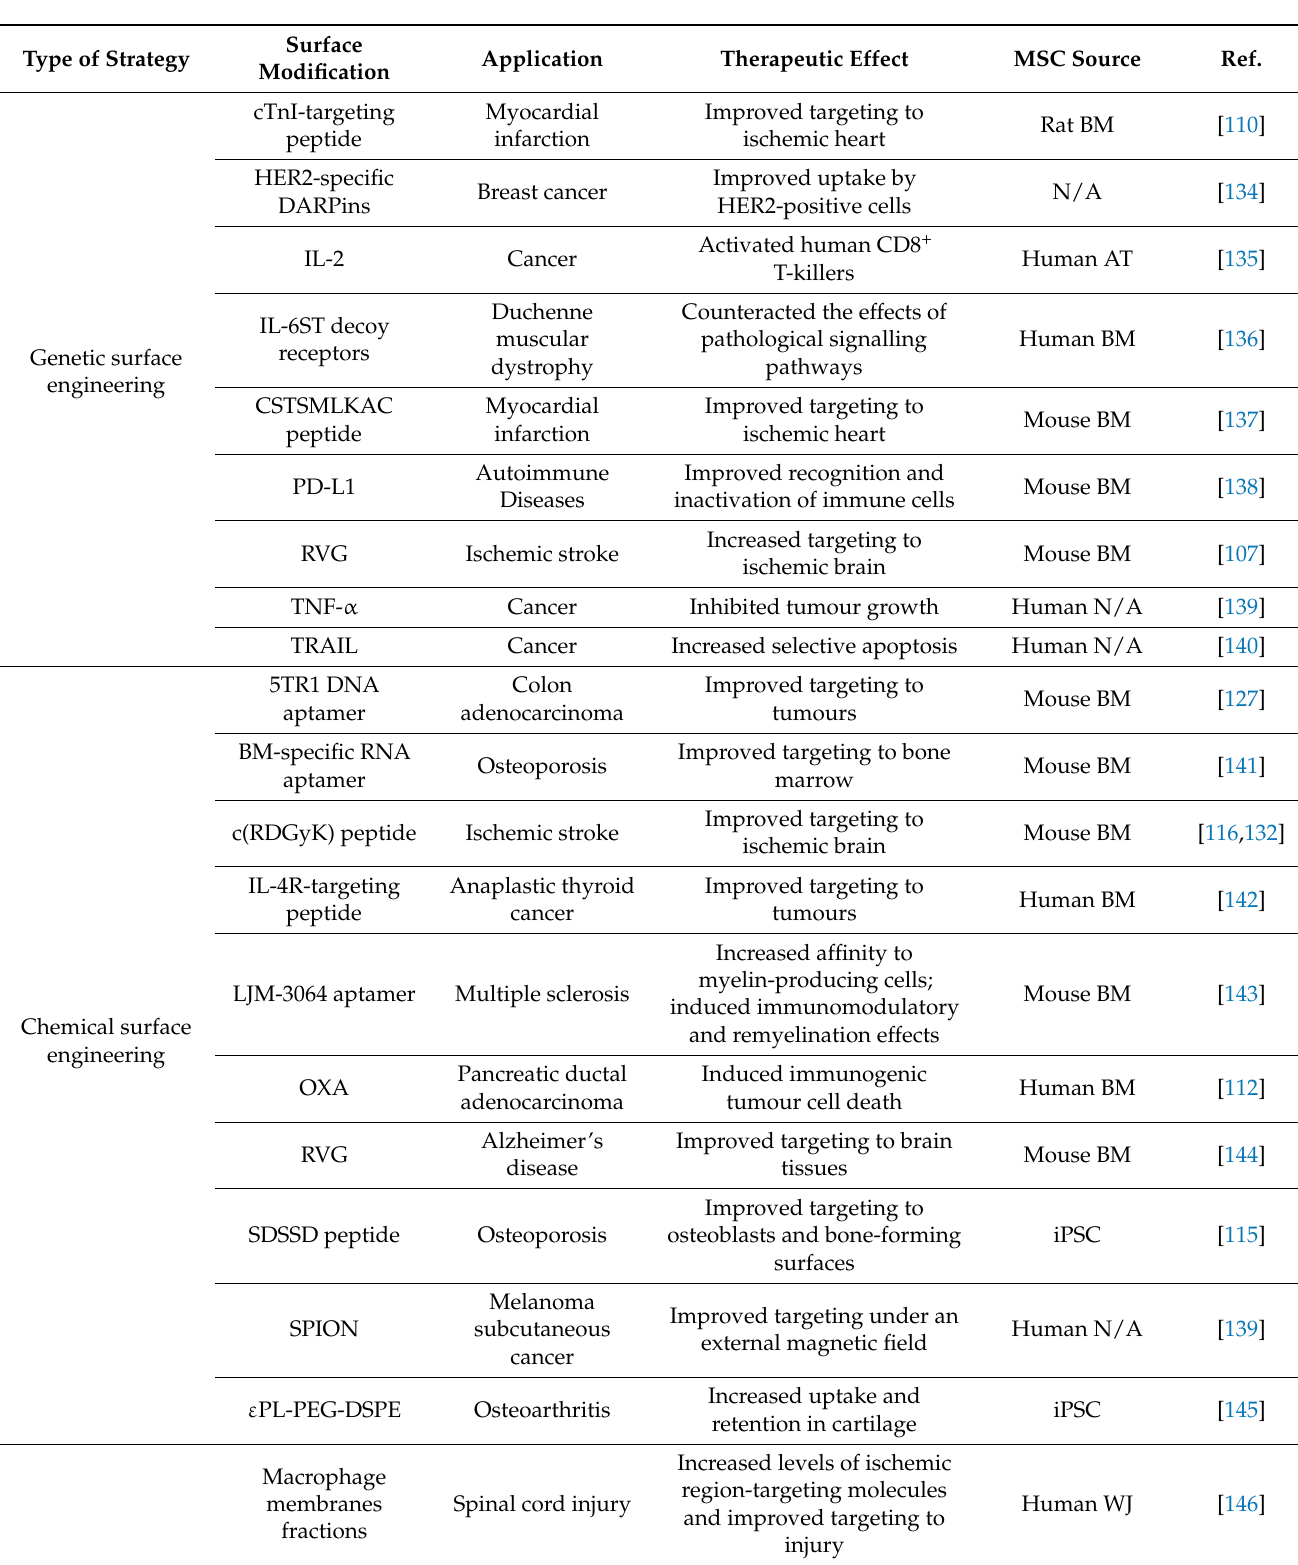
Table 2. Overview of the potential strategies and applications of surface-engineered mesenchymal- stromal-cell-derived extracellular vesicles